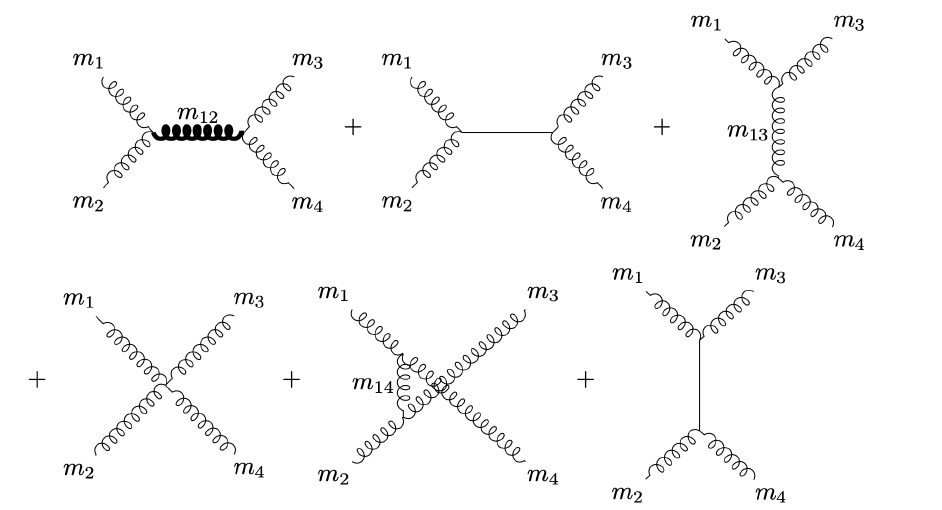
Figure 3 . Feynman diagrams showing the AA → AA process for the first case of m I + m J = 0 , i.e. m 1 + m 2 = 0 and m 3 + m 4 = 0 . The bold curly line represents a gluon, where m 12 = 0 and the straight line a scalar field. The last diagram, where we have a scalar exchange in the t -channel contributes to the second case of m I + m J = 0 where m 1 = − m 2 = m 3 = − m 4